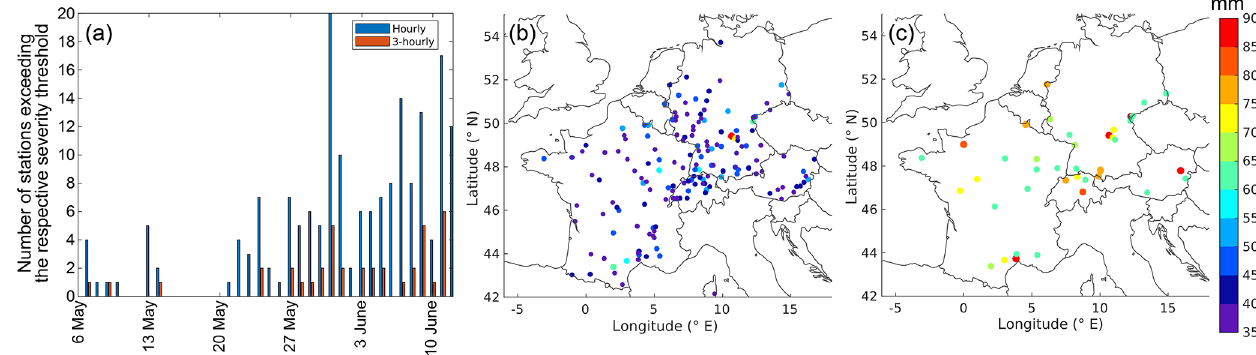
Figure 3. (a) Time series of the number of stations exceeding precipitation thresholds of > 35mm over 1h (blue) and > 60mm over 3h (red), including the location and the maximum of (b) 1h and (c) 3h accumulation of the respective station during the study period (22 May to 12 June). Table 1. List of 1, 3, and 24h rainfall totals records (in UTC) within the study domain during the study period (AT is Austria, FR is France, GE is Germany). Note that 24h value means precipitation between 00:00 and 00:00UTC the next day. Note that some stations only provide reports for the full 24h (e.g. Bruchweiler, Mauth-Finsterau). Further analyses regarding rain duration (RD), track length (in km), and propagation speed (in ms − 1 ) are limited to Germany due to data availability. RD3 means a rain duration with a rain rate > 3mmh − 1 , RD35 is > 35mmh − 1 , and RD60 is > 60mmh − 1 . Note two tracks for the German events could not be identified by TRACE3D due to the overlapping of several cells, which were relatively